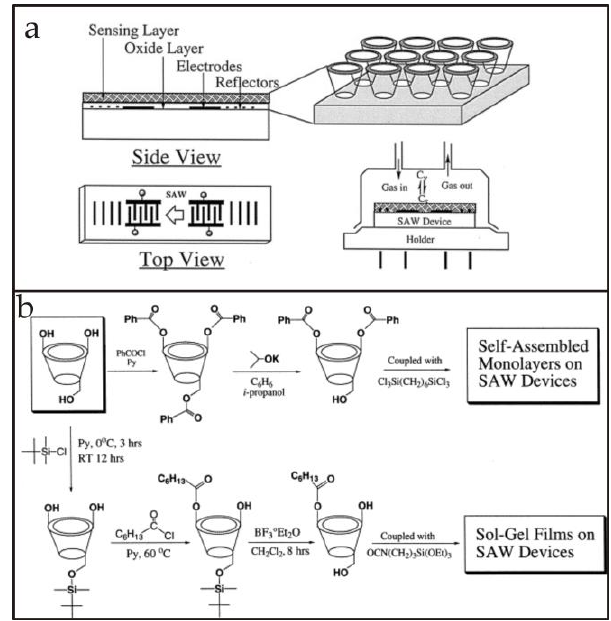
Figure 5. ( a ) Schematic representation of a SAW device with a side view showing the cone shaped cyclodextrin-based monolayer receptors. Furthermore, the device was integrated with a four pin holder which was covered with a special lid having openings for gas inlets and outlets thus, showing the design of measuring cell, whereas ( b ) shows the chemical reactions for synthesizing self-assembled monolayers as well as sol-gel films that were coated on SAW devices. Adapted with permission from [58], copyright (2000) Elsevier.